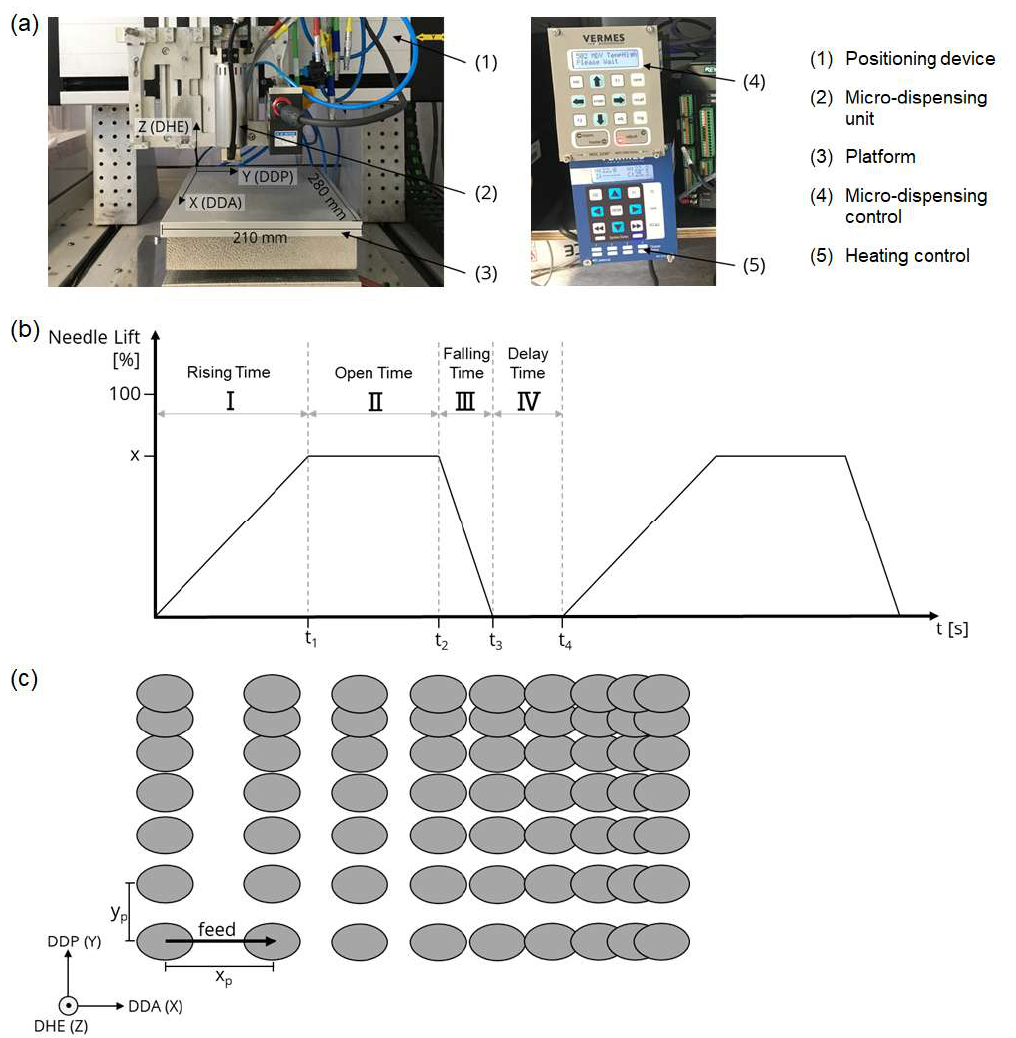
Figure 2. ( a ) Experimental setup; ( b ) the typical dosing cycle with the temporal characteristics; and ( c ) the part generation CerAM MMJ: the droplets turn into lines, the lines turn into areas.